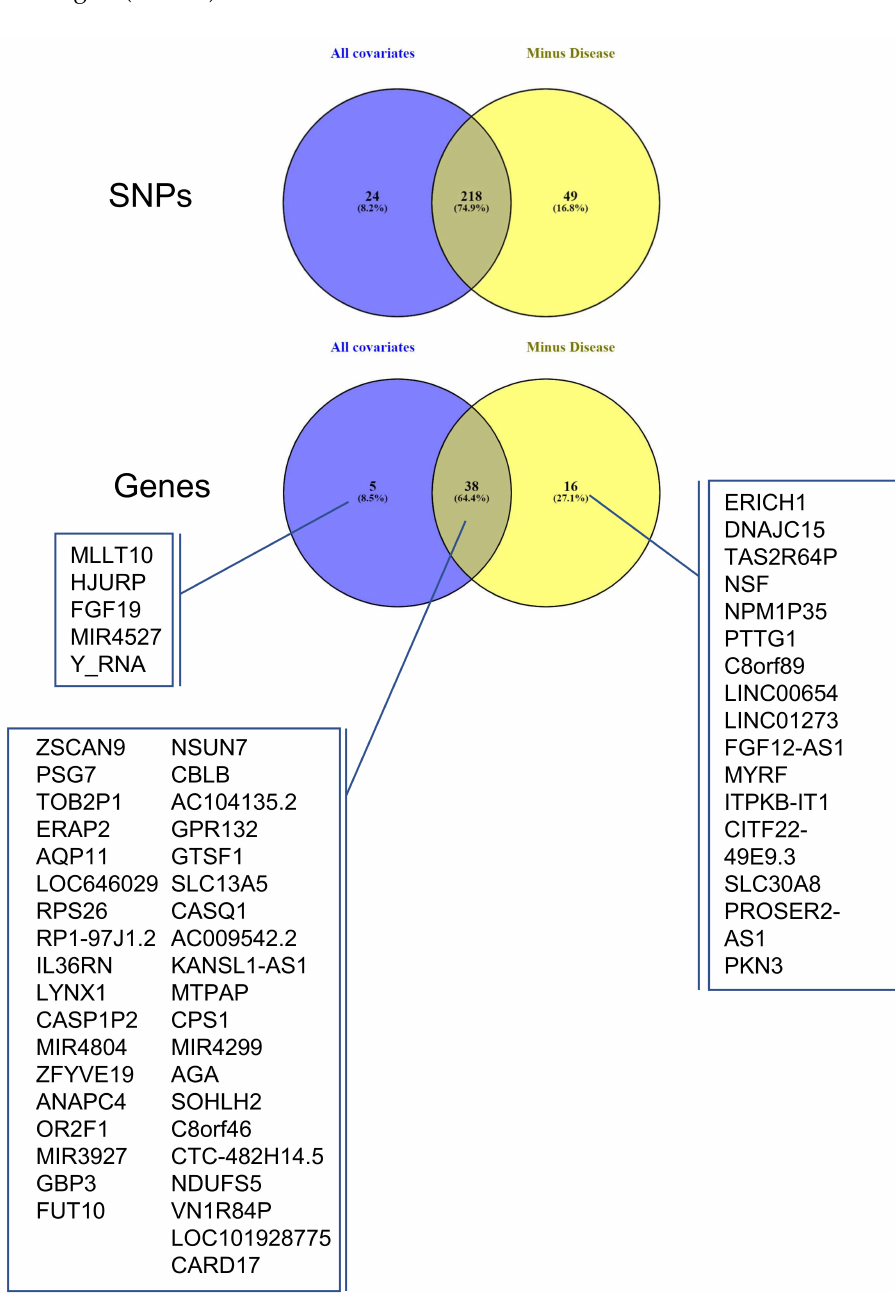
Figure 5. Overlap between cis-QTL datasets ALL COVARIATES and MINUS DISEASE. Venn dia- grams showing the overlap between the eSNPs and eGenes identified as statistically significant (FDR ≤ 0.05) in ALL COVARIATES (blue) and MINUS DISEASE